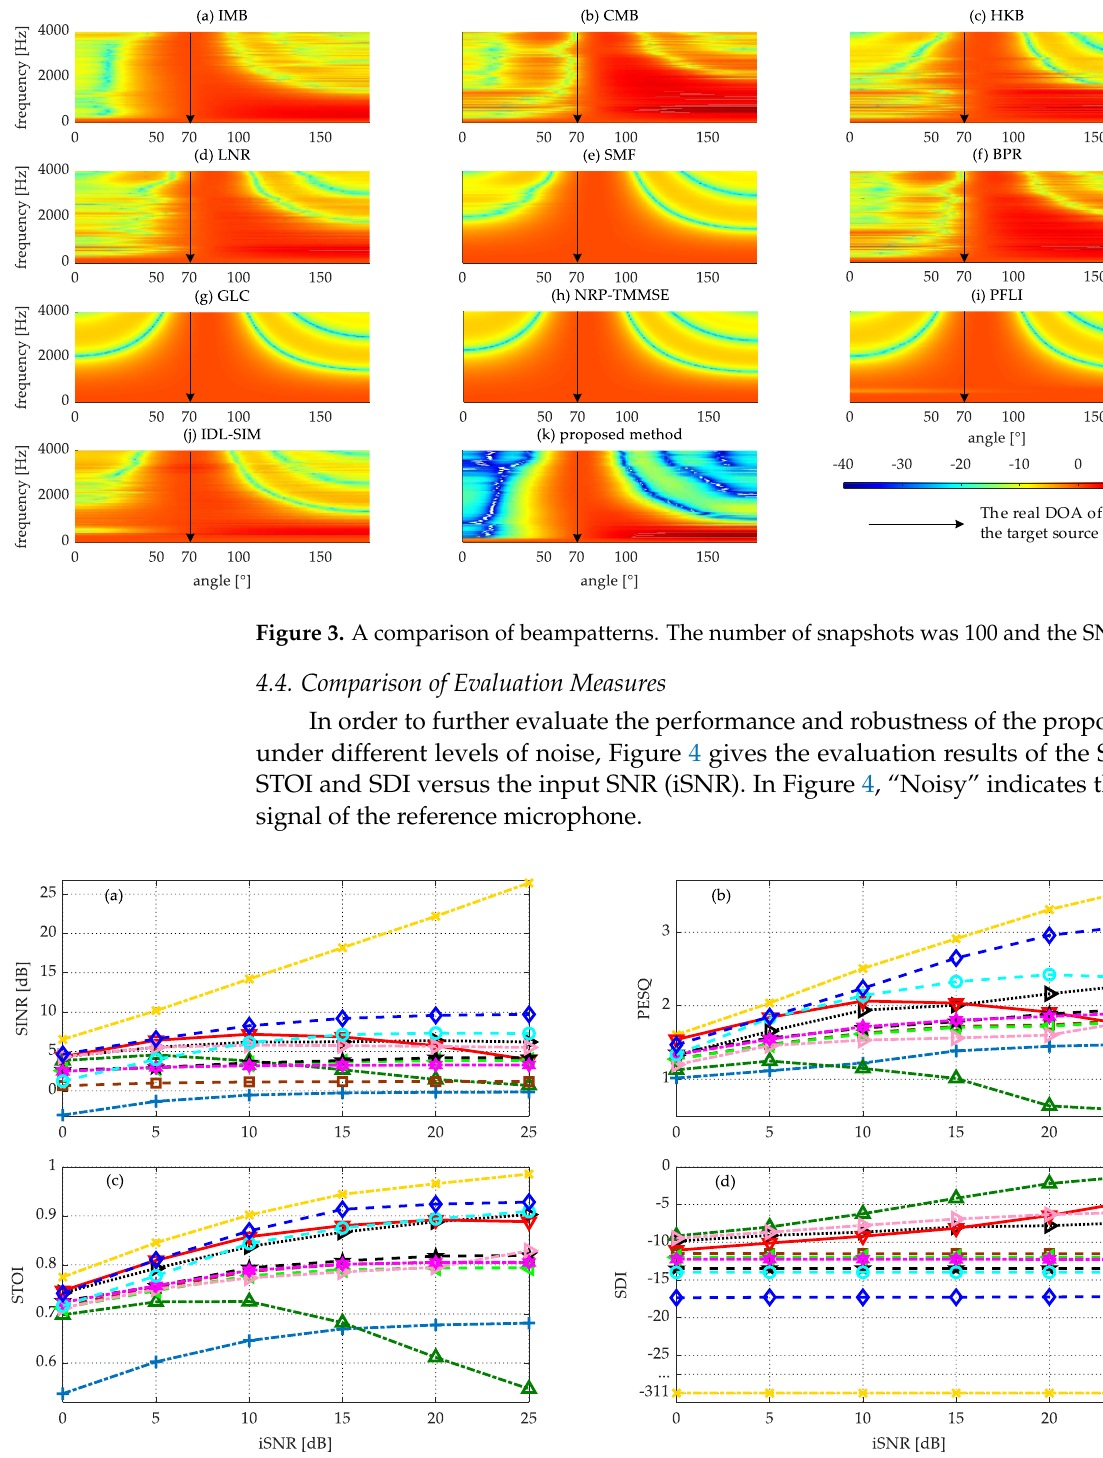
Figure 4. The results of the evaluation measures under different iSNRs: (a) SINR; (b) PESQ; (c) STOI; (d) SDI.